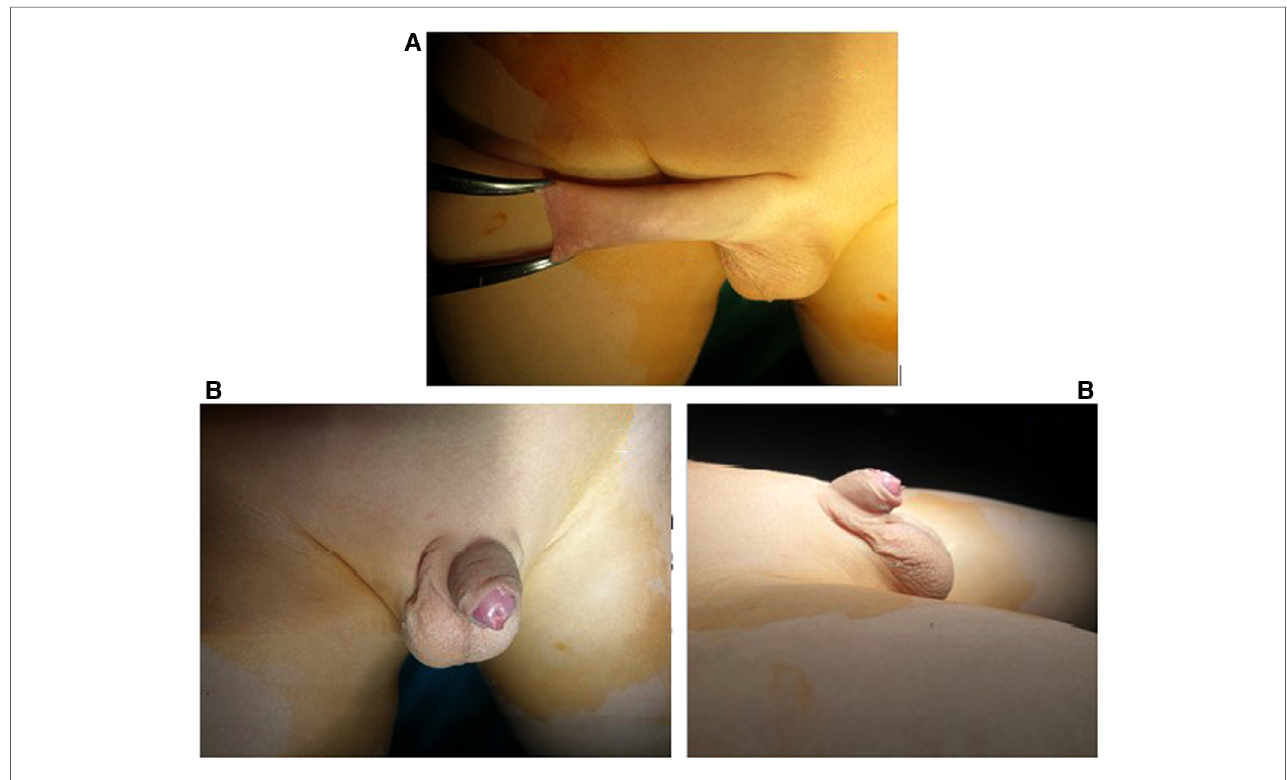
FIGURE 2 Circumcision with leaving around 5mm of mucosal collar.